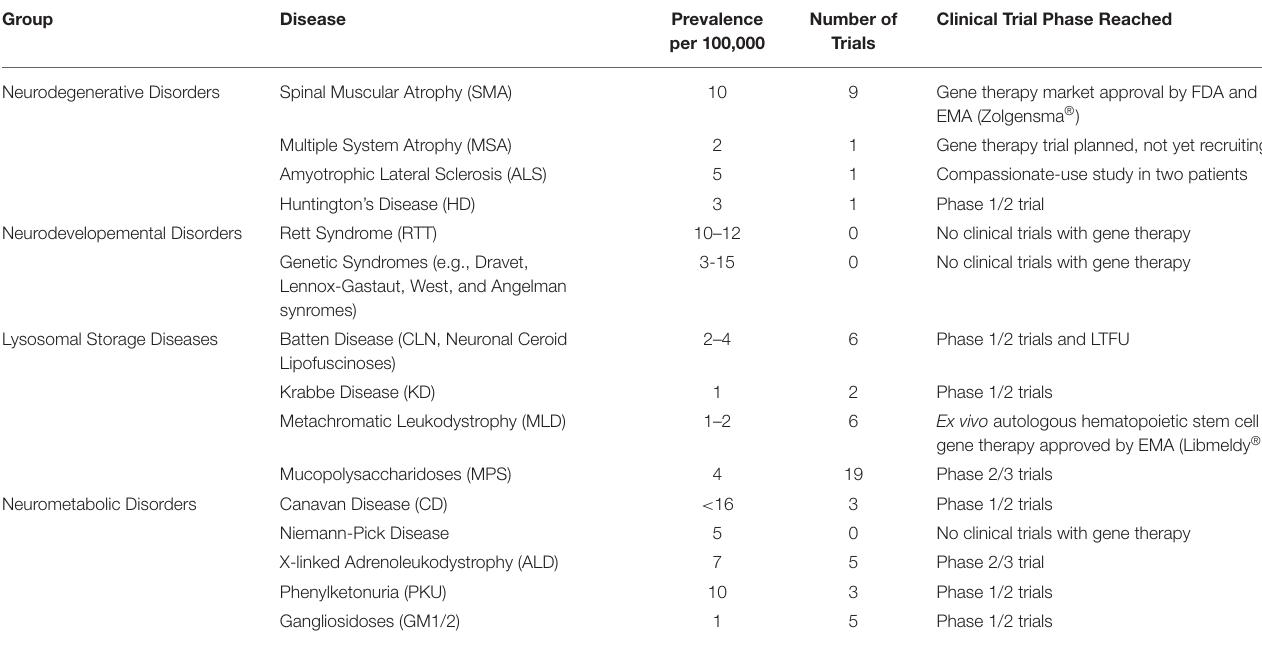
TABLE 1 | Overview of clinical gene therapy trials for groups of rare genetic diseases affecting the brain and spinal cord found on https://clinicaltrials.gov 1st of May 2021.